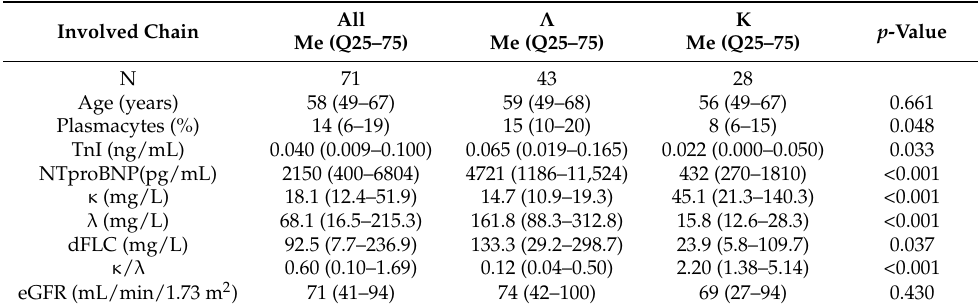
Table 1. Laboratory and clinical findings from enrolled patients.